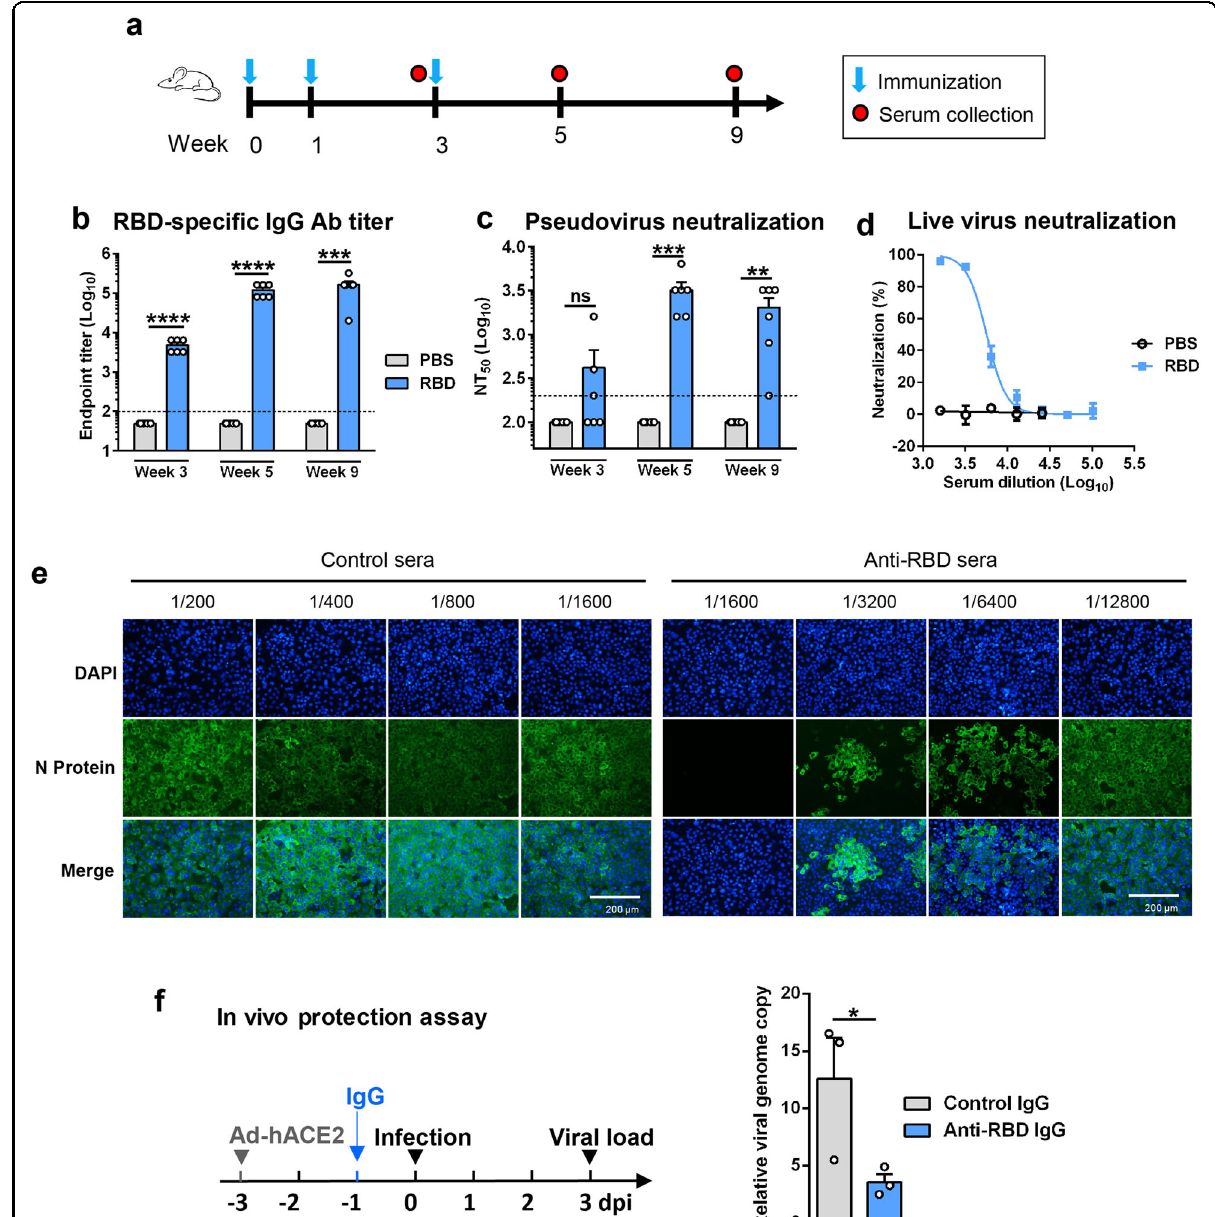
Fig. 2 Immunization with yeast-derived monomeric RBD elicited protective antibodies in mice. a Immunization schedule. Groups of six BALB/ c mice were injected i.p. with alum-formulated monomeric RBD protein (50 μ g/dose) or PBS at weeks 0, 1, and 3. Serum samples were collected from individual mice at weeks 3, 5, and 9. b RBD-binding antibody (Ab) titers of the immune serum samples determined by ELISA. Binding titer below 1:100 (the lowest serum dilution; indicated by dashed line) was assigned a value of 1:50 for statistical analysis. c Measurement of neutralization activity of the antisera against SARS-CoV-2 pseudovirus. Serum samples that exhibited less than 50% neutralization at the lowest serum dilution (1:200; dashed line) were assigned a NT 50 value of 100 for statistical analysis. Each symbol represents one mouse. d , e Neutralization activity of the pooled week-9 antisera against authentic SARS-CoV-2. Live SARS-CoV-2 was incubated with serially diluted antisera and then added to VeroE6 cells. After 48 h culture, the cells were subjected to qRT-PCR ( d ) or immuno fl uorescent staining analysis ( e ). Scale bars, 200 μ m. f In vivo protective ef fi cacy of IgG antibody puri fi ed from the week-9 antisera against authentic SARS-CoV-2 infection. Left panel: study outline. Ad5-hACE2, recombinant adenovirus 5 expressing human ACE2. Right panel: qPCR results are shown as viral RNA levels relative to GAPDH, using 2 − Δ Ct method. Each symbol represents one mouse. Data in panels b , c , d , and f are expressed as means ± SEM. Statistical signi fi cance was determined by Student ’ s t -test and indicated as follows: ns, not signi fi cant; * P < 0.05; ** P < 0.01; *** P < 0.001; **** P <